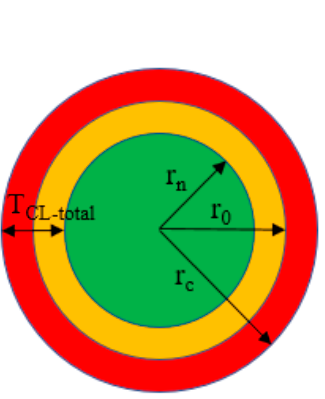
Figure 10. Schematic of the radius change of steel bar under corrosion.